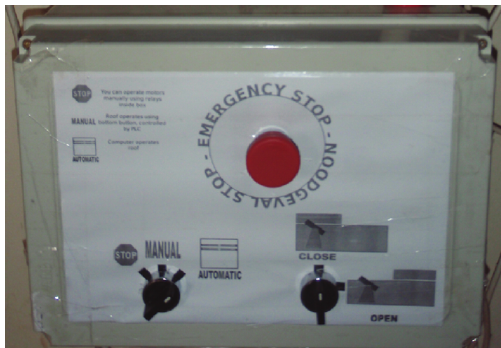
Figure 3: Roof control box switches. Switching roof to manual or stop also stops autonomous observations. Unlike (graphical) user interfaces running on computers, it is very unlikely that this panel will fail. Watcher telescope, Boyden Observatory, Republic of South